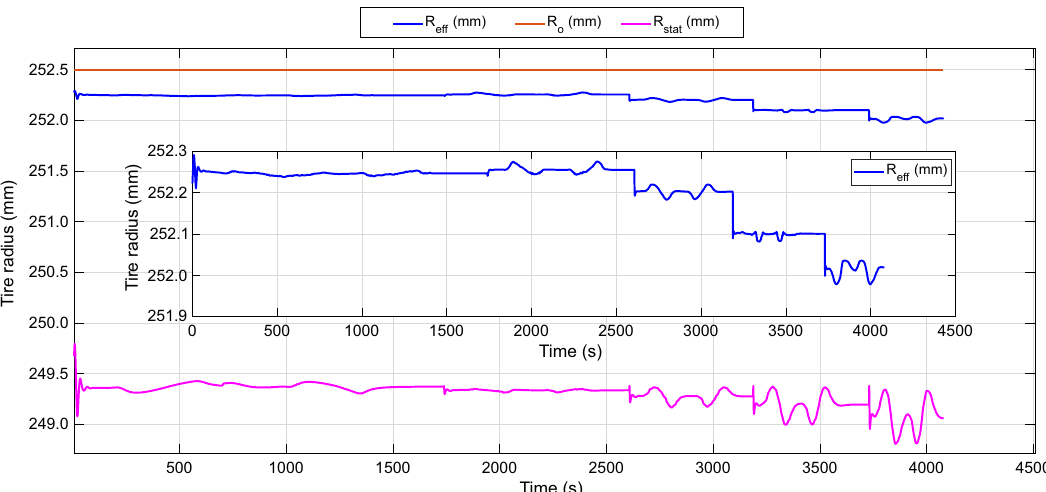
Figure 19. Comparison between the estimated effective radius, R ef f , the static radius, R stat , and the undeformed radius, R o , of the tire under the DLC maneuver at different